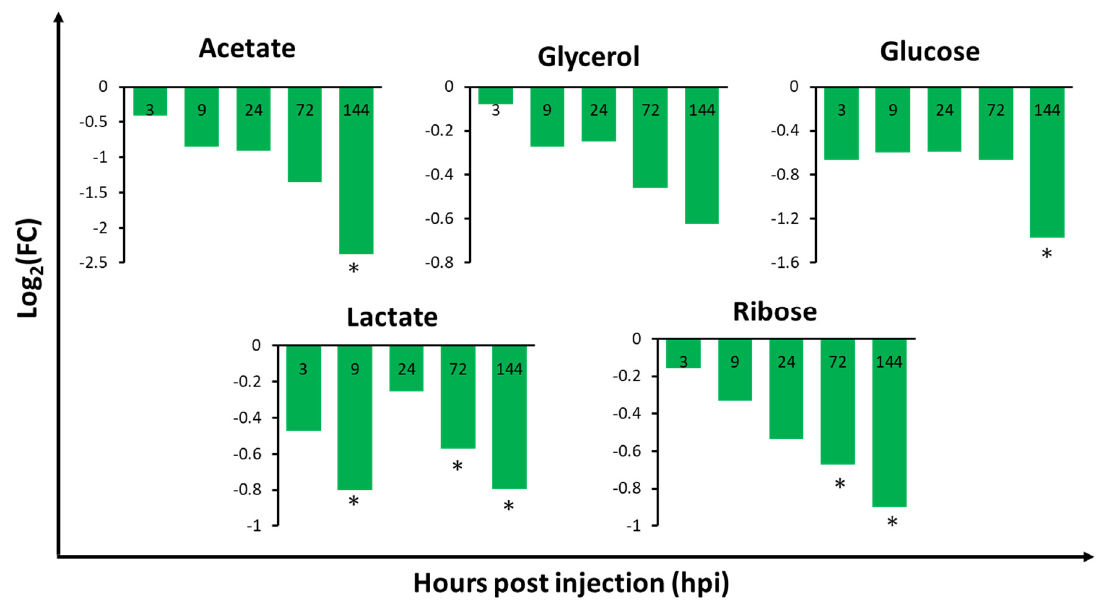
Figure 3. Fold change of relative metabolite concentrations in the gills of whiteleg shrimp ( Litopenaeus vannamei ) infected with Vibrio harveyi when compared to 0 hpi in the control group. Values with an asterisk (*) indicate significant differences when compared to 0 hpi in the control group ( p < 0.05) ( n = 3).